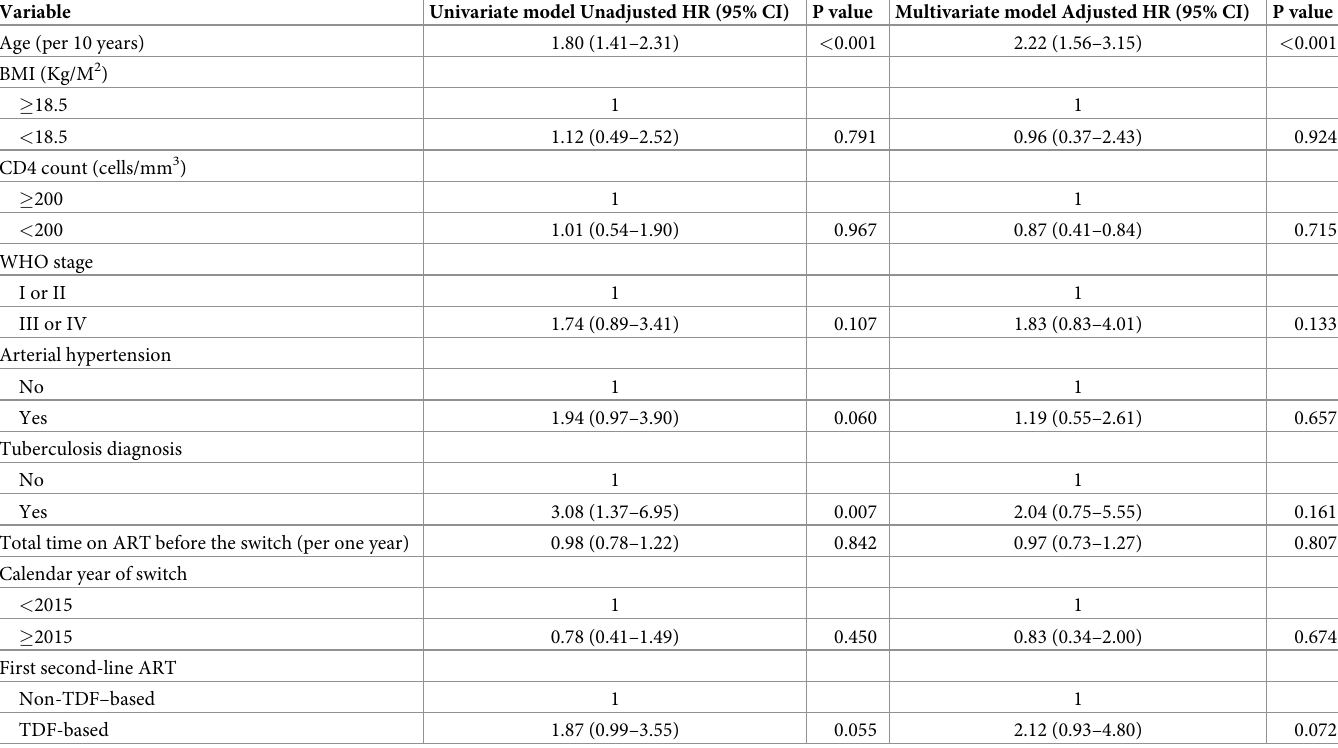
Table 3. Univariate and multivariate Cox proportional hazards for predictors of renal impairment (with baseline covariates) (n = 556).